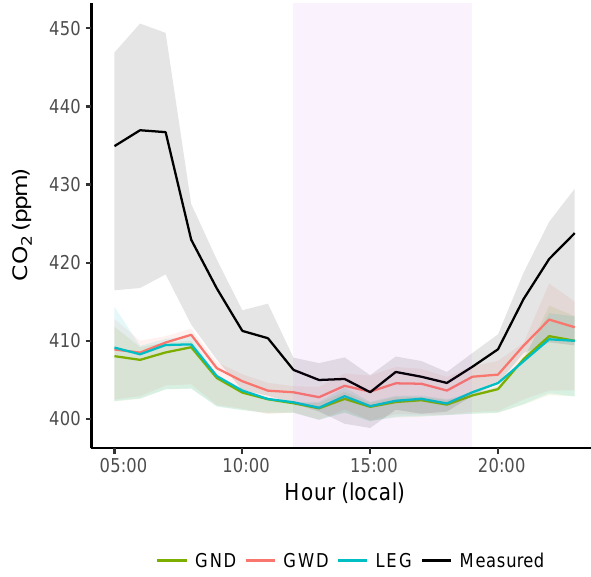
Figure 5. Mole fractions of various footprint calculation methods by hour of day during light-rail operating hours from early morning to late evening. Purple shading indicates afternoon hours (05:00– 23:00 local daylight time) used for analyses. Solid lines represent the mean and shading represents the interquartile range. Mole frac- tions modeled by footprints calculated using the Gaussian kernel algorithm with the correction for HNF dilution depth (GWD) agree most closely with measurements, with underestimation attributed to sub-grid-scale sampling of emissions